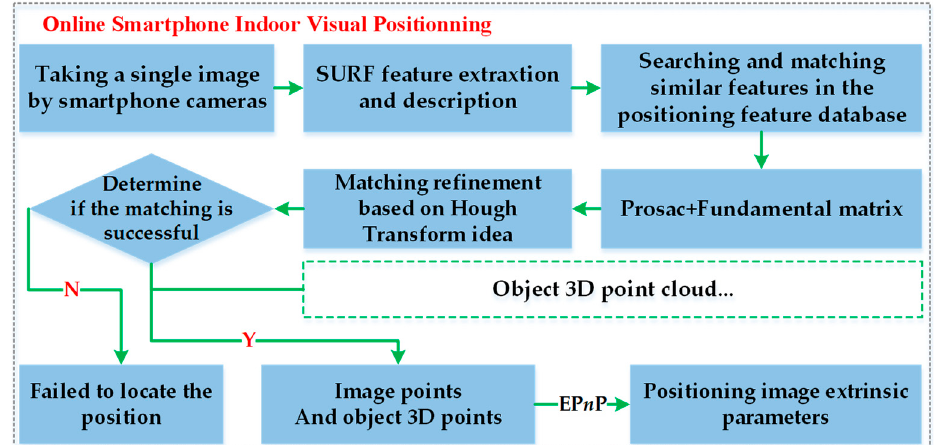
Figure 4. The workflow of single smartphone image positioning.